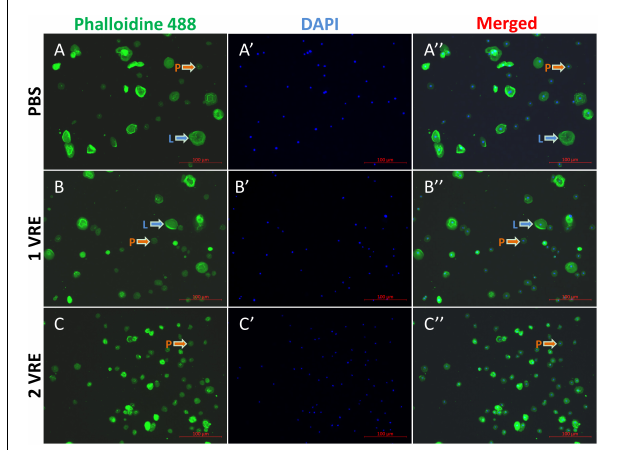
FIGURE 1 | Immunofluorescence detection of hemocytes after venom treatment. The stained hemocytes incubated with PBS (A–A (cid:48)(cid:48) ) , 1 VRE (B–B (cid:48)(cid:48) ) , or 2 VRE (C–C (cid:48)(cid:48) ) were photographed using fluorescence microscope. Subsequently, the staining area was counted. Plasmatocytes (P) and lamellocytes (L) are each indicated. Blue represents the nuclei stained with 4 (cid:48) , 6-diamidino-2-phenylindole (DAPI) and green represents the cytoskeleton marked with phalloidin